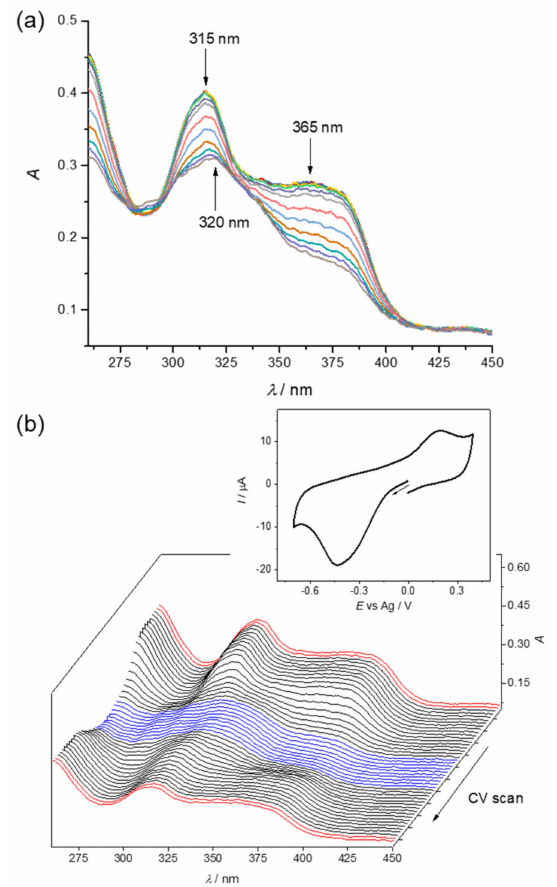
Figure 8. UV / Vis spectra measured upon cathodic reduction of ca. 0.1 mM aqueous solution of 1 at pH 7 at the first reduction peak by using a honeycomb platinum working electrode (scan rate 10 mV s − 1 ). ( a ) UV / Vis spectra measured upon cathodic reduction in the forward scan and ( b ) UV / Vis spectra measured during one cyclic voltammetric scan (inset: the corresponding in situ cyclic voltammogram). A similar e ff ect was observed for 2 and 3 in MeCN / 0.1 M n Bu 4 NPF 6 (Supplementary